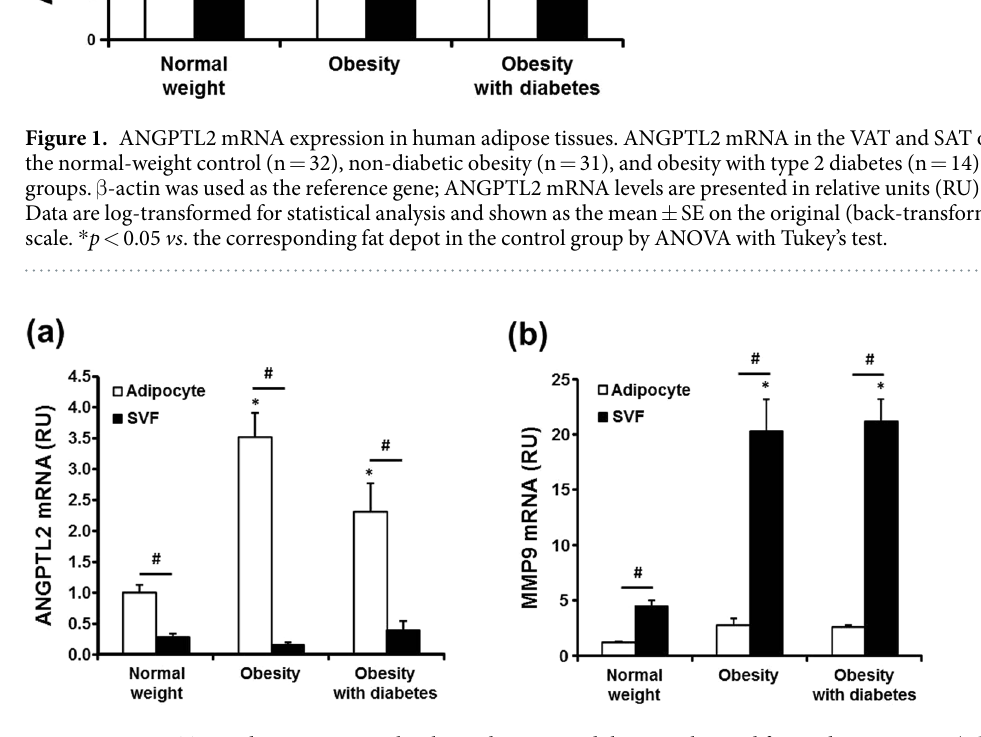
Figure 2. ANGPTL2 and MMP9 mRNA levels in adipocyte and the SVF obtained from adipose tissues. ( a , b ) VAT of normal-weight women ( n = 8) who received benign gynecological surgery and non-diabetic obese women ( n = 8) and obese women with type 2 diabetes ( n = 4) who received RYGB surgery, were removed during surgery and digested with collagenase to separate floating adipocytes and non-floating SVF. β -actin was used as the reference gene. * p < 0.05 vs . control group by ANOVA with Tukey’s test, # p < 0.01 vs . adipocyte by paired t